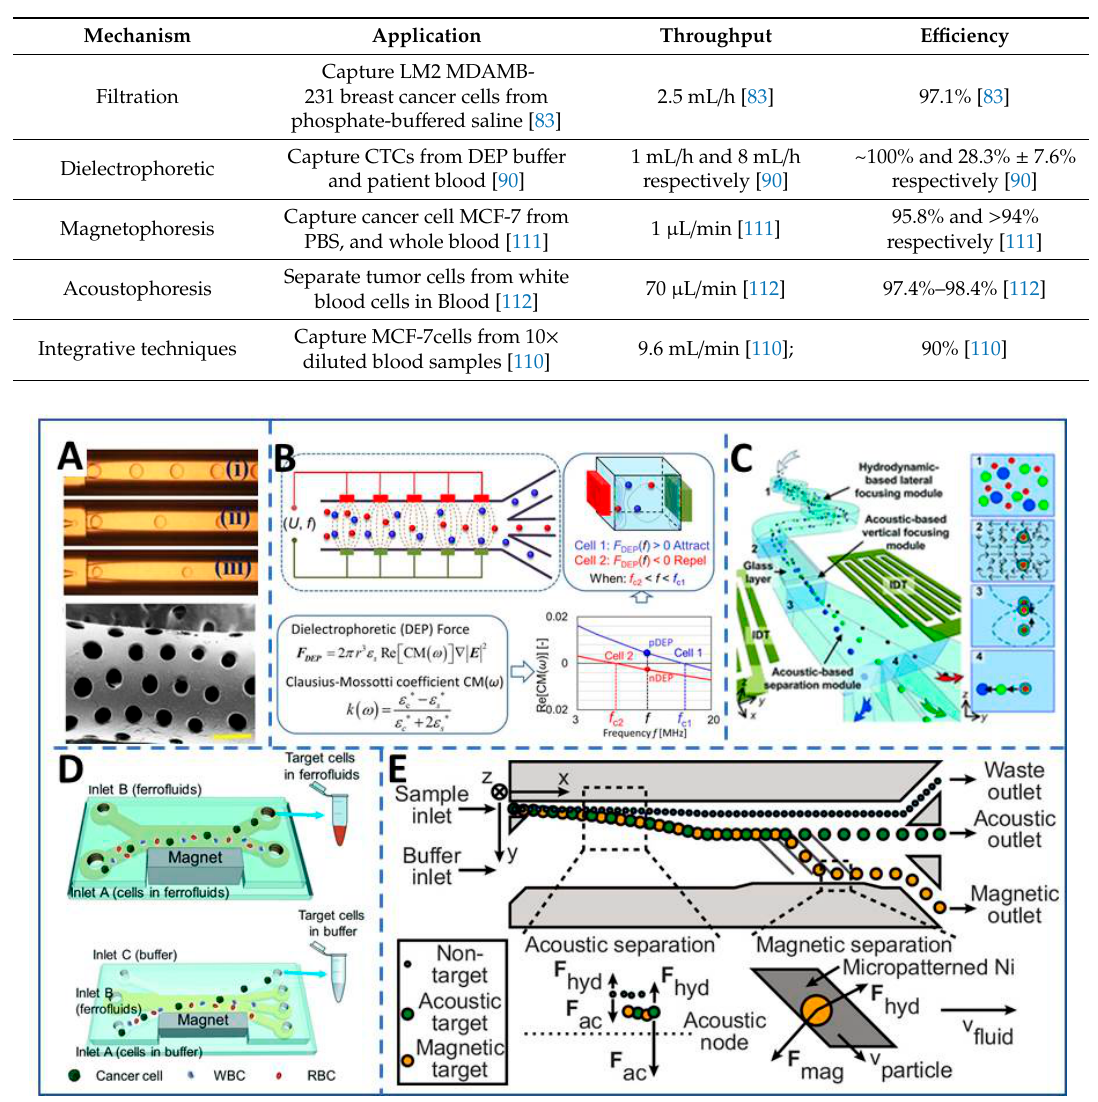
Table 1. The display and compare the throughput and e ffi ciency of diverse mechanisms for capturing circulating tumor cells (CTCs) from mimicking / real blood samples.